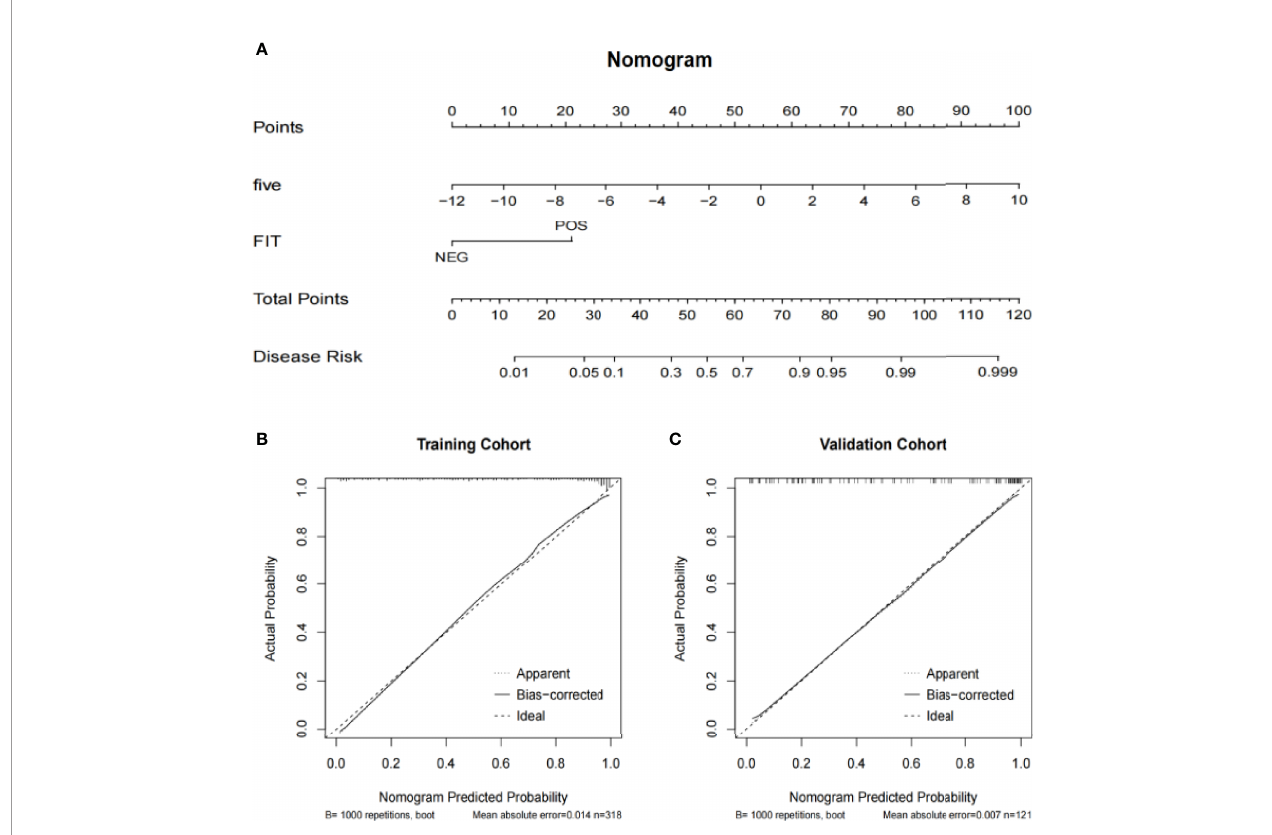
FIGURE 6 | The nomogram of the risk prediction models for colorectal cancer. (A) Nomogram of the colorectal cancer risk prediction model combined with FIT. (B) The training cohort prediction calibration curve of the colorectal cancer risk prediction model combined with FIT. (C) The validation cohort prediction calibration curve of the colorectal cancer risk prediction model combined with